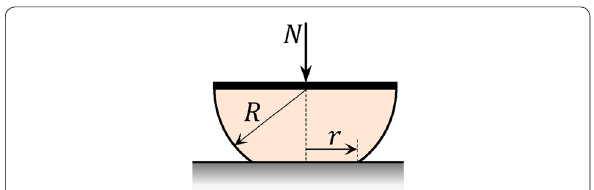
Fig. 6 Contact Interface of a hemispherical soft finger under a normal